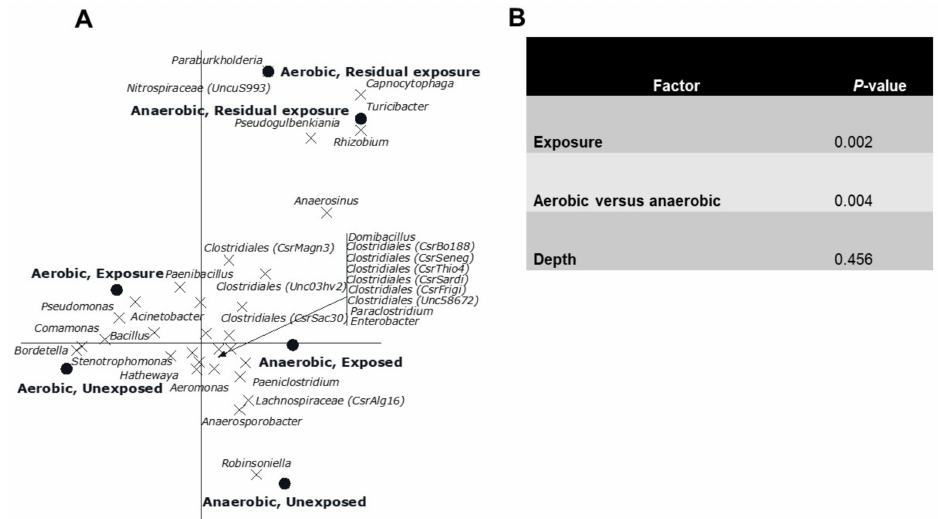
Figure 5. ( A ). Canonical correspondence analysis biplot showing the results of the analysis using the interaction between exposure and being aerobic or anaerobic as explanatory variables and depth as covariable. Of all variance, 32% was explained by the di ff erences between sites while the covariables explained 2% of the variation in genus composition. Of the variation explained by the explanatory variables, 41% is displayed on the horizontal axis and an additional 32% on the vertical one. Only the 32 genera of which more than 15% of its variation is displayed by the axes are shown. ( B ). Significance of the e ff ects of the di ff erent factors on the genus composition of the bacterial community as assessed by Monte Carlo permutation